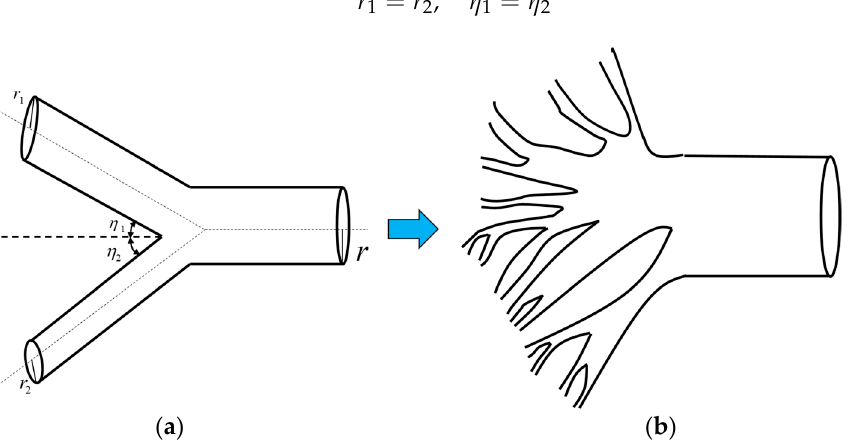
Figure 3. Path of compression waves converging into a shock wave. ( a ) single-stage bifurcation structure. ( b ) multistage bifurcation